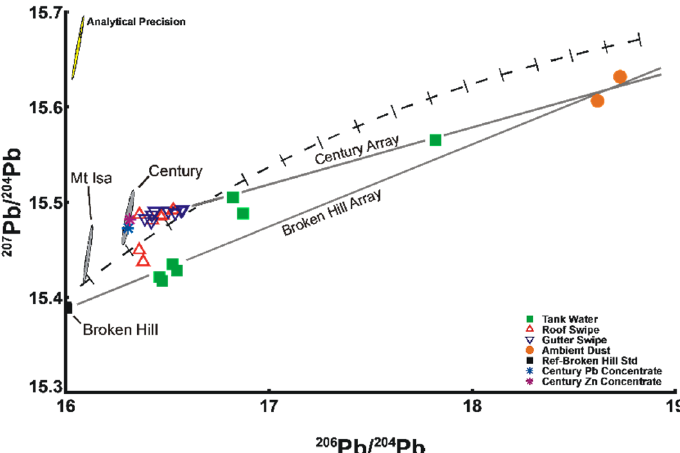
Figure 3. Isotopic ratio plot of the uranium derived Pb isotopes 207 Pb/ 204 Pb versus 206 Pb/ 204 Pb showing the resolution between the Century and Broken Hill sources in water samples. The conservative precision of the isotopic measurements is shown by the 95% confidence ellipse in the upper left hand corner. The dashed line is the Growth Curve or Pb Evolution Curve for massive sulfides. The ellipses for Century and Mt Isa are drawn in grey and the value for Broken Hill denoted by the filled square. Lines have been drawn between the Century field and the background ambient dust sample data points, termed the Century Array. A similar line can be drawn through the Broken Hill value and the background data points (the Broken Hill Array).